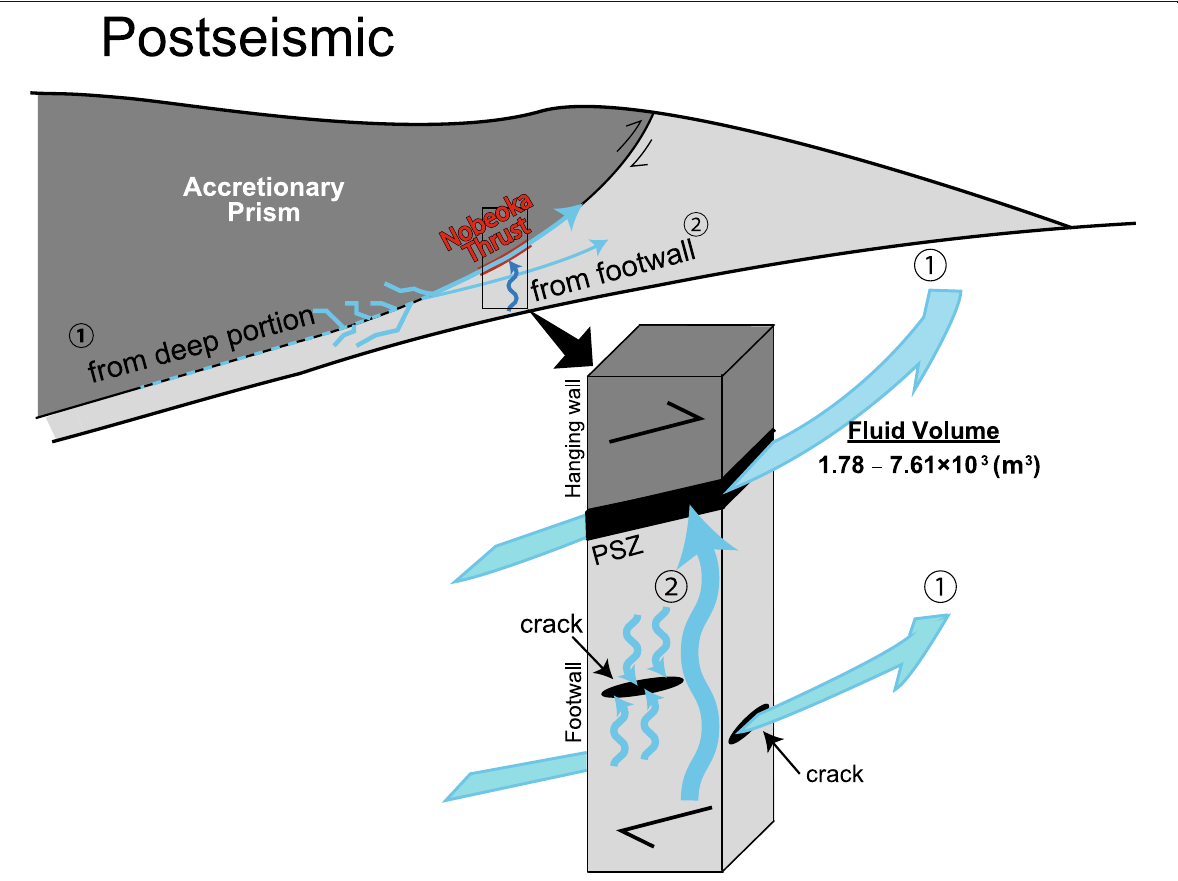
Fig. 11 Schematic illustration showing postseismic fluid discharge along the Nobeoka Thrust. The upper figure shows a cross-section of the subduction zone. The lower figure shows fluid supply from deep reservoir or footwall mélange. The fluid that reacted with the fault rocks was enriched in Li and Cs, and the fluid volume was estimated to be 1.78 – 7.61 × 10 3 m